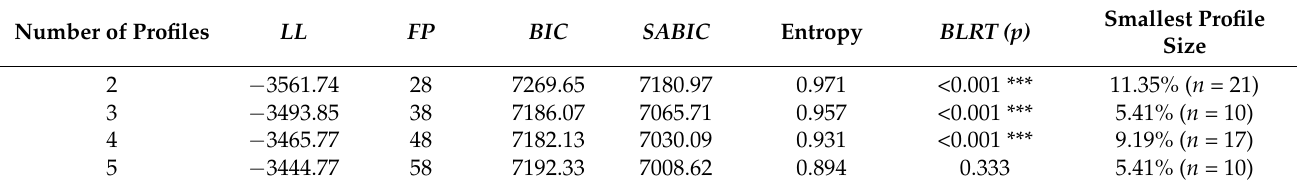
Table 2. Fit indices for profile solutions.